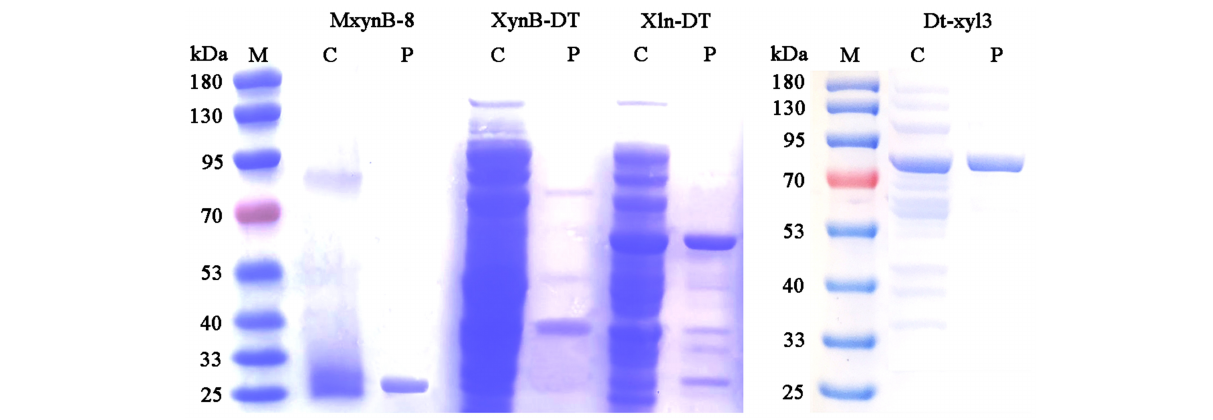
TABLE 2 | Enzymatic hydrolysis of different xylans and other substrates in 6h by MxynB-8 and XynB-DT. Source MxynB-8 XynB-DT XOS yield (%) Distribution of X1–X6 (%) XOS yield (%)